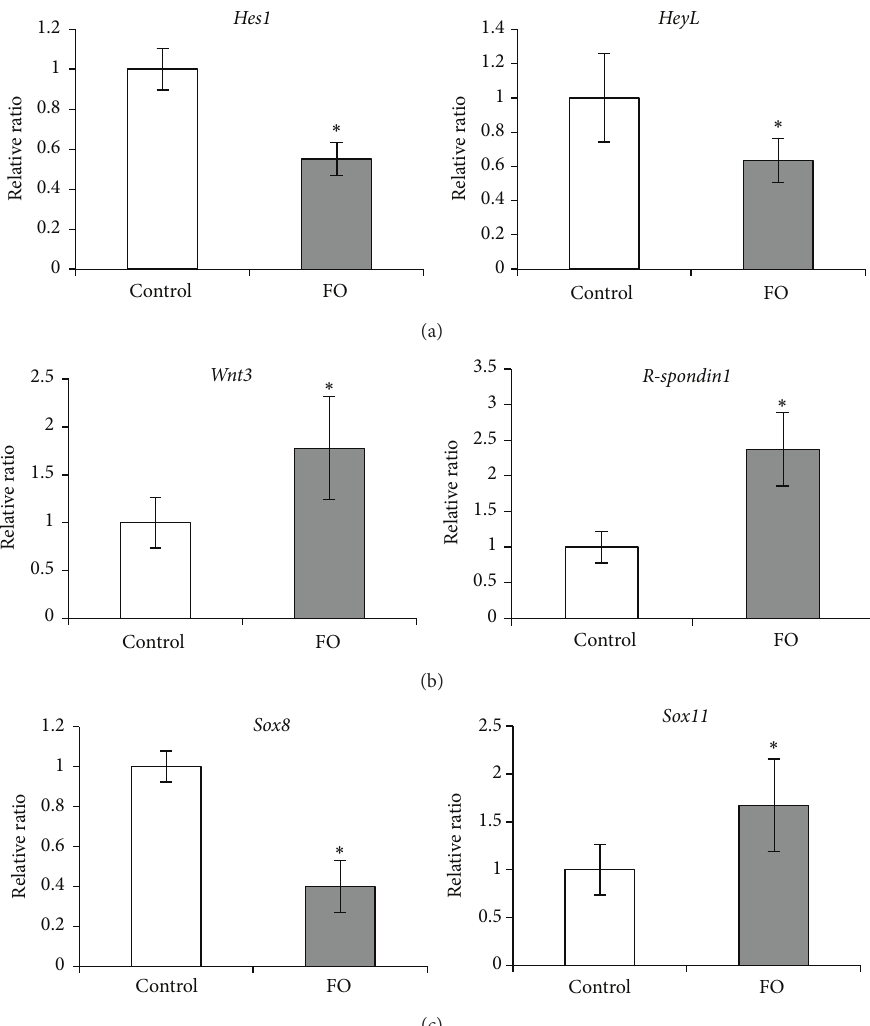
Figure 4: Changes in Notch, Wnt, and Sox expression following functional overload. (a, b, c) Expression levels of Notch signaling-related genes, Wnt signaling-related genes, and Sox genes. Amounts of Hes1 and HeyL (a), Wnt3 and R-spondin1 (b), and Sox8 and Sox11 (c) mRNAs in the plantaris were measured by qRT-PCR analysis. Target mRNA expressions were normalized to that of RPL32 and then plotted as the expression ratio relative to control group. All values are expressed as mean ± SDM (𝑛 = 5) . Significant differences: ∗ compared to control group (𝑃 < 0.05)